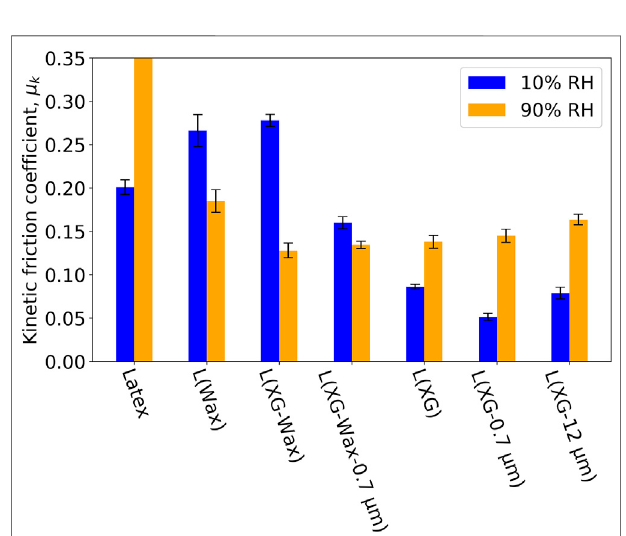
FIGURE 5 | Kinetic friction coef fi cient for a range of samples tested at 20 ° C and two RH conditions. Error bars indicate the standard deviation.